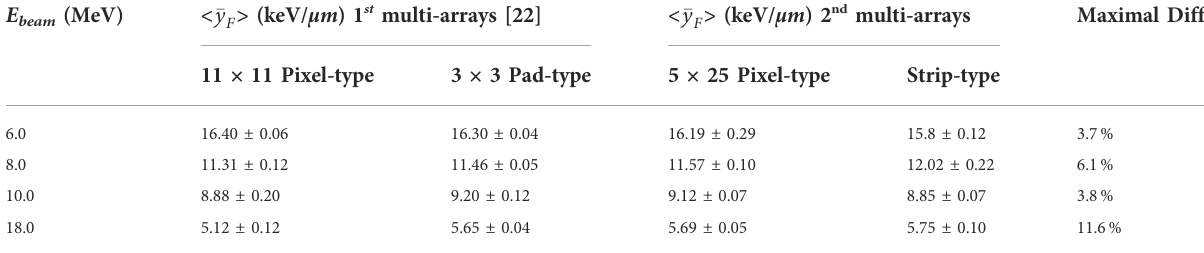
TABLE 3 Values of < (cid:1) y F > , σ < (cid:1) y , obtained with the fi rst multi-array systems characterized in ALTO [22] (left) and the results obtained with the current F > multi-arrays (right) for four representative energies. E beam